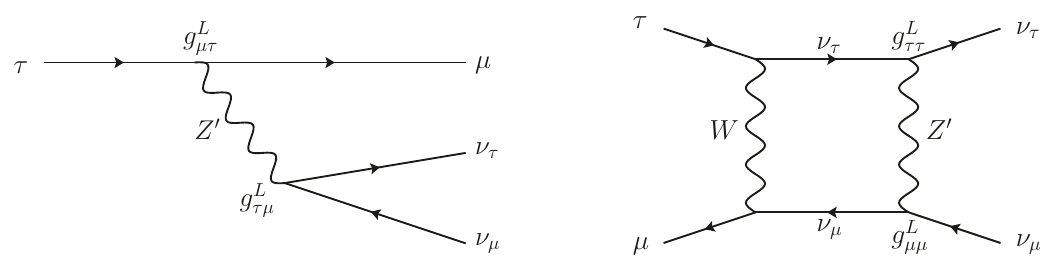
Figure 1. Feynman diagrams illustrating the leading Z 0 -contributions to the process τ → µν τ ¯ ν µ . In the presence of flavour off-diagonal Z 0 -couplings, the process arises already at tree-level (see left diagram), whereas in the case of flavour-diagonal couplings, corrections to τ → µν by four boxes, one of which is shown on the